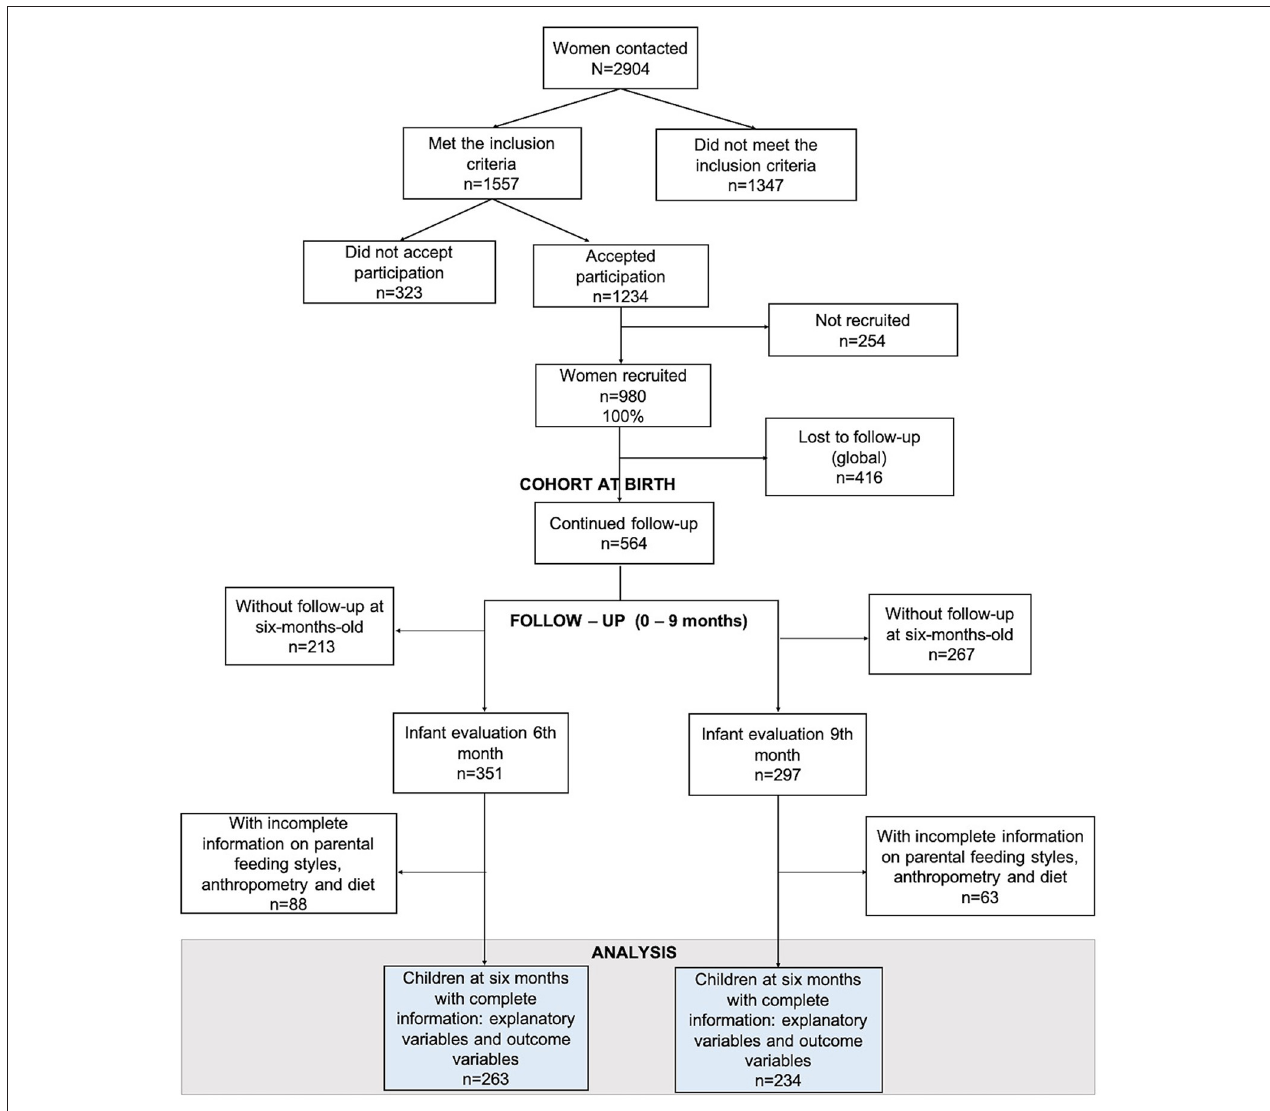
FIGURE 1 | Study sample from the MAS-Lactancia birth